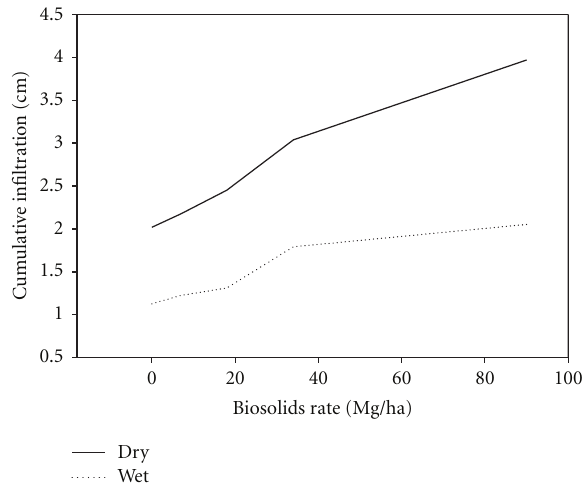
Figure 7: Cumulative infiltration for wet or dry conditions in bare treatments for the Stellar soil as a function of biosolids rate on the Sierra Blanca Ranch.